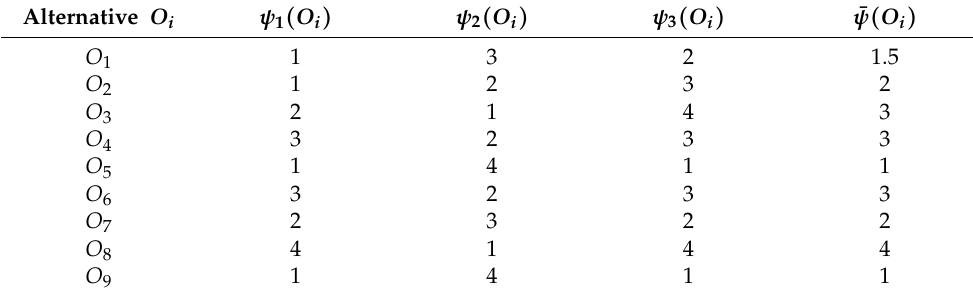
Table 18. Final ranking results of the ontology